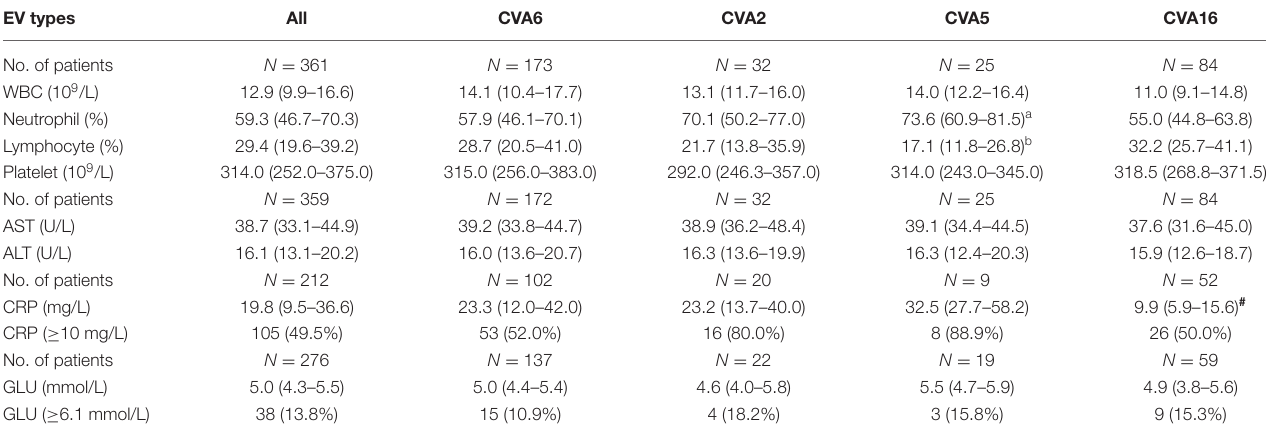
TABLE 4 | Laboratory features of patients infected with different EVs on admission in this study.